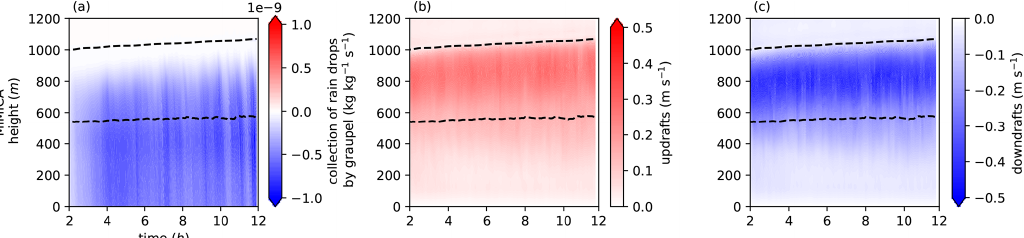
Figure A8. (a) Collection of raindrops by graupel, (b) updrafts and (c) downdrafts with time, as simulated by MIMICA. The first 2h of simulations, considered as the spin-up period, are excluded. For figure clarity, the plot titles have been abbreviated; the first number refers to the accumulation mode and the second to the Aitken mode concentration in cubic centimetres, i.e. 3_20 refers to AC3_AK20. Black dashed lines represent the cloud top and cloud base heights.